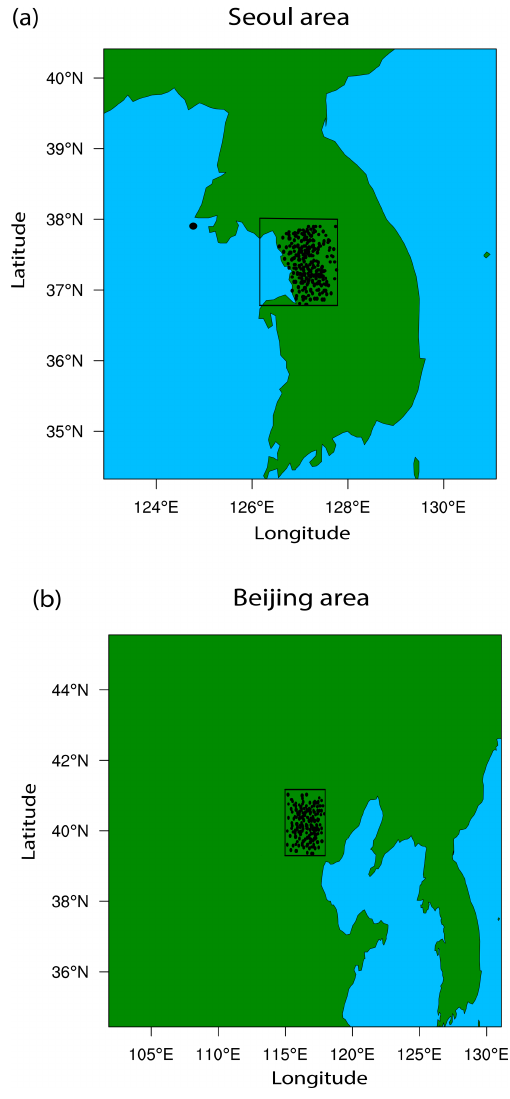
Figure 1. Inner rectangles in (a) and (b) mark the Seoul area in the Korean Peninsula and the Beijing area in the East Asia continent, respectively. A dot outside the inner rectangle in (a) marks Baekry- ongdo island. Dots in the inner rectangles in (a) and (b) mark the selected locations where precipitation and aerosol mass are mea- sured. In (a) and (b) , the light blue represents the ocean and the green the land